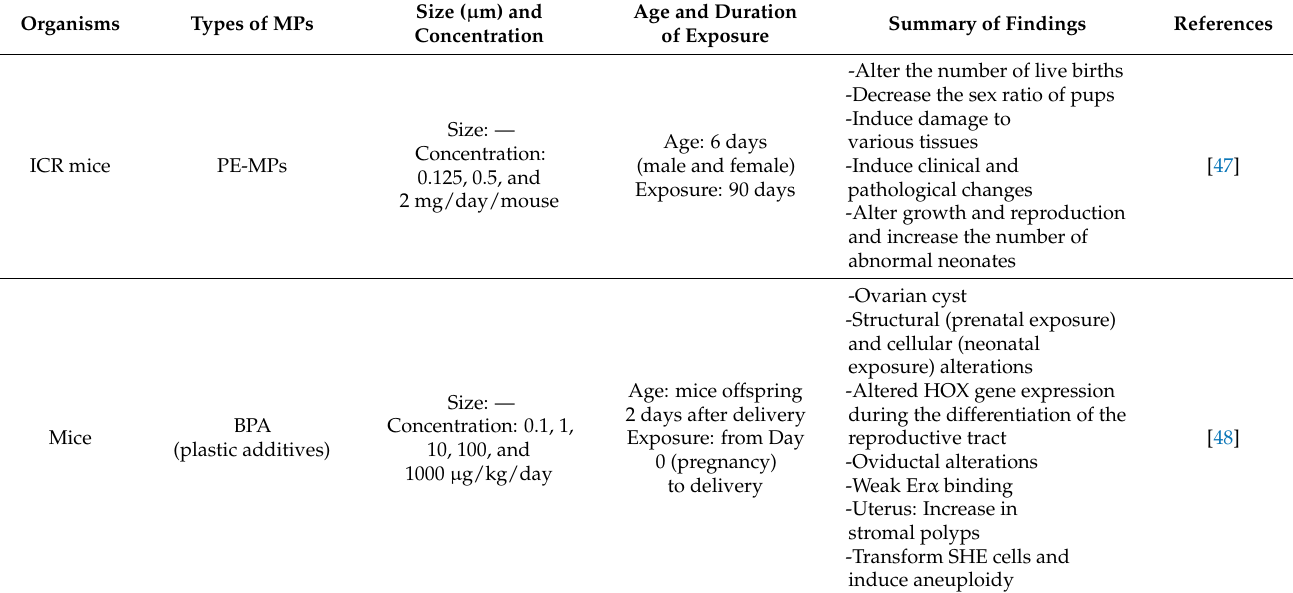
Table 2. Summary of the effects of MPs exposure on the reproductive system during the early developmental